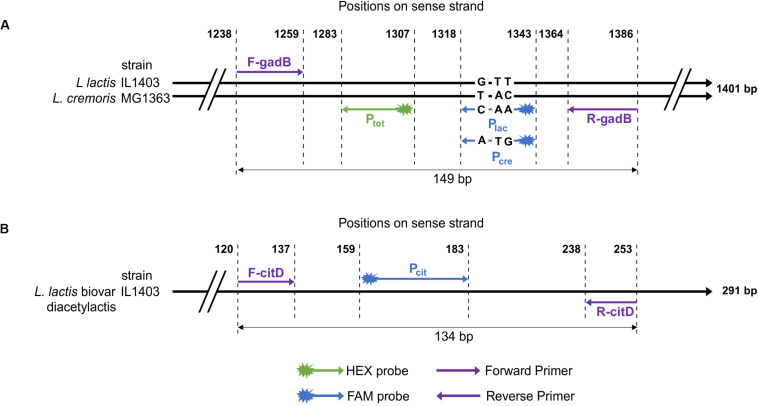
Schematic representation of the positions of primers and probes for: (A)
gadB gene of two Lactococcus strains. IL1403 and MG1363 strains belong, respectively, to lactis and cremoris species. Positions are aligned on the 1401 bp sequence of the gadB gene of IL1403 strain. Nucleotides between positions 1318 and 1343 correspond to lactis and cremoris genotypes probes. (B)
citD gene sequence of IL1403 strain.